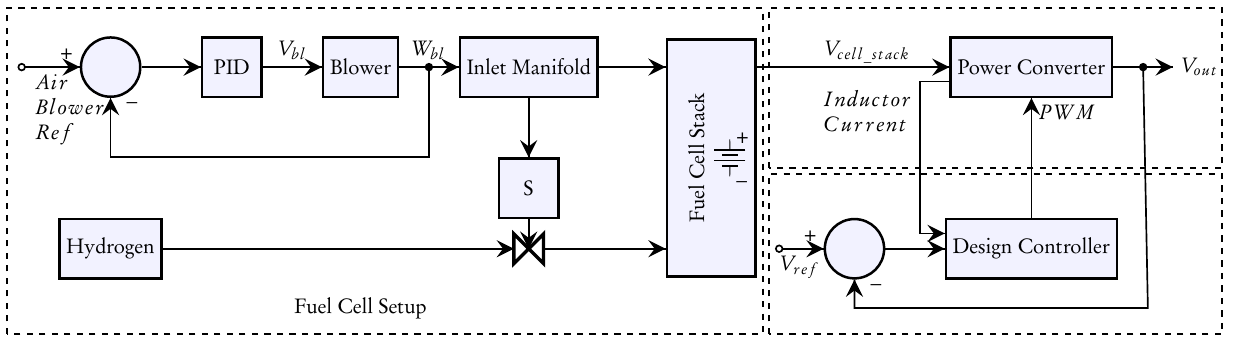
Figure 1. Fuel cell setup with power control circuitry and its control